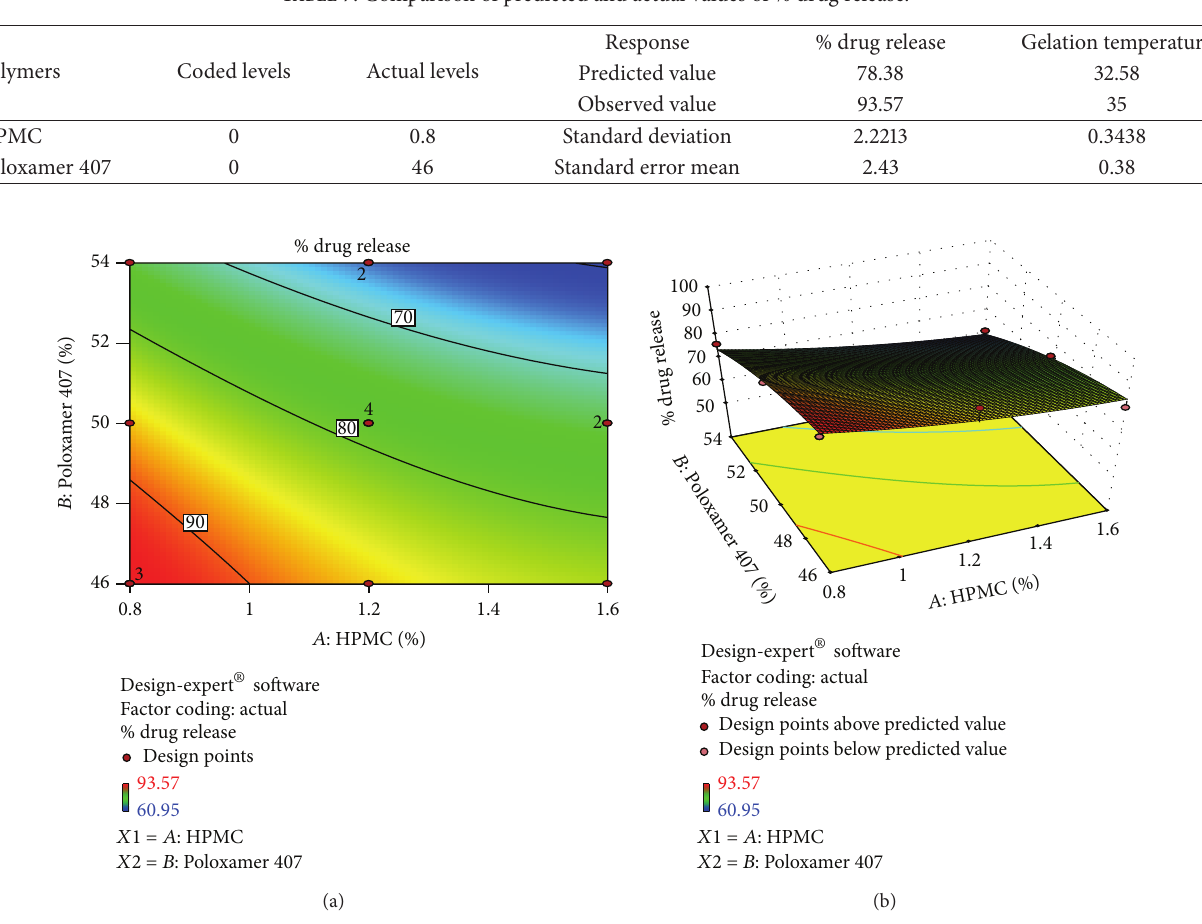
Figure 5: (a) Contour plot. (b) Response surface plot showed relationship in between % drug release at 480 min and polymer